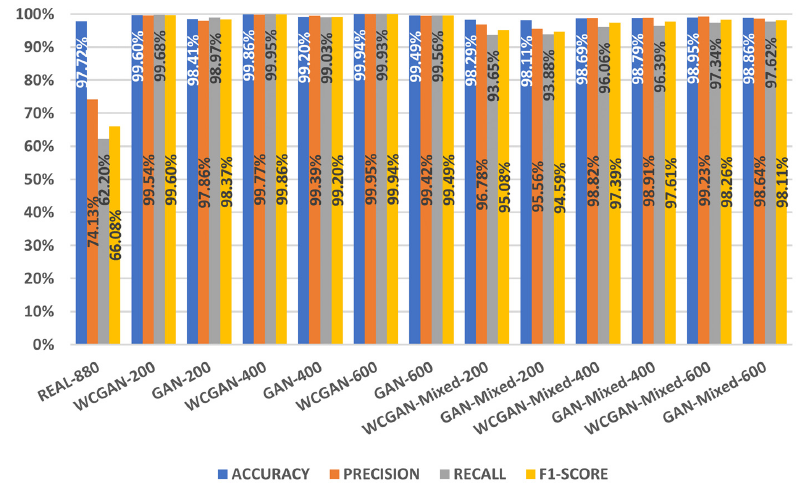
Figure 16. Histograms of the performance of our 13 GB-based classifiers on our 13 test sets.